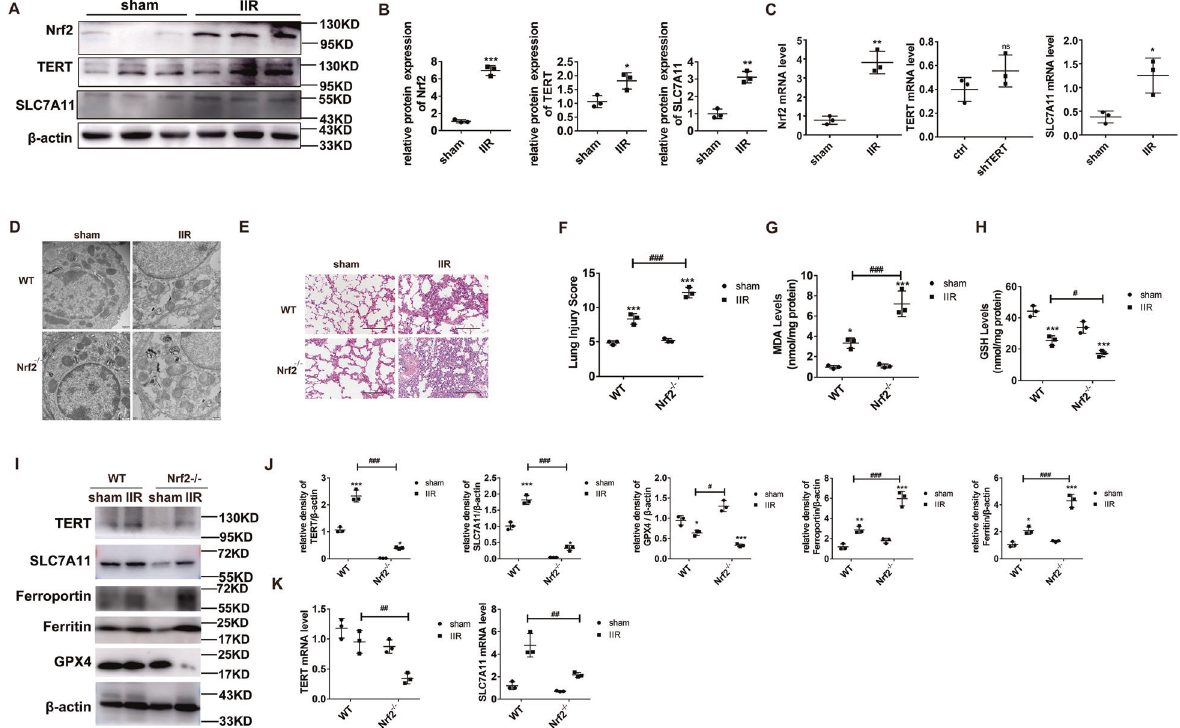
Fig. 2 The Nrf2/TERT/SLC7A11 axis is activated during II/R and the ferroptotic process is dysregulated in the Nrf2 − / − mice after II/R. A Evaluation of Nrf2 and its potential downstream targets in the murine lung tissues, under different conditions, as evidenced by western blotting. B Quanti fi cation of the examined proteins. C mRNA levels of the examined factors. D Representative transmission electron micrographs of the lung tissue ultrastructures. Scale bar: 500 nm. E HE staining of lung sections, observed under a light microscope. Scale bar: 200 μ m. F Pathological scores, as determined by an experienced pathologist. G MDA levels under different conditions. H GSH levels under different conditions. I Evaluation of essential proteins involved in ferroptosis regulation within lung tissues, under different conditions. J Quanti fi cation of the examined proteins. K mRNA levels of the examined factors. Error bars denote standard error from three individual experiments. Data are expressed as mean ± SEM. * P < 0.05; ** P < 0.01; *** P < 0.001. # relative to the IIR-WT mice.